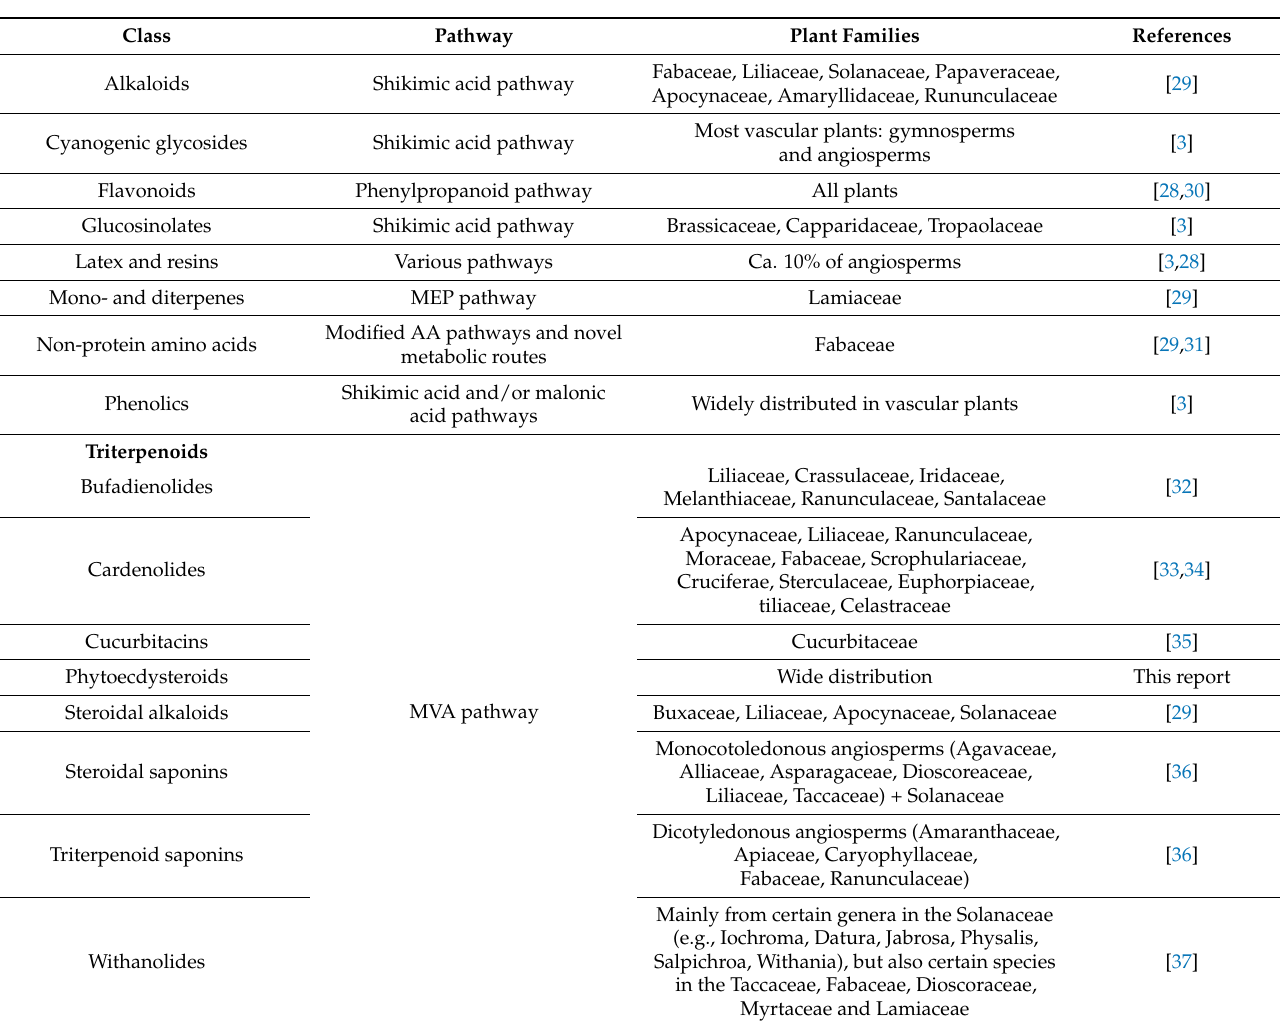
Table 2. Distribution of the main classes of plant secondary metabolites according to plant families with emphasis on triterpenoids (modified and extended from Kariñho-Betancourt